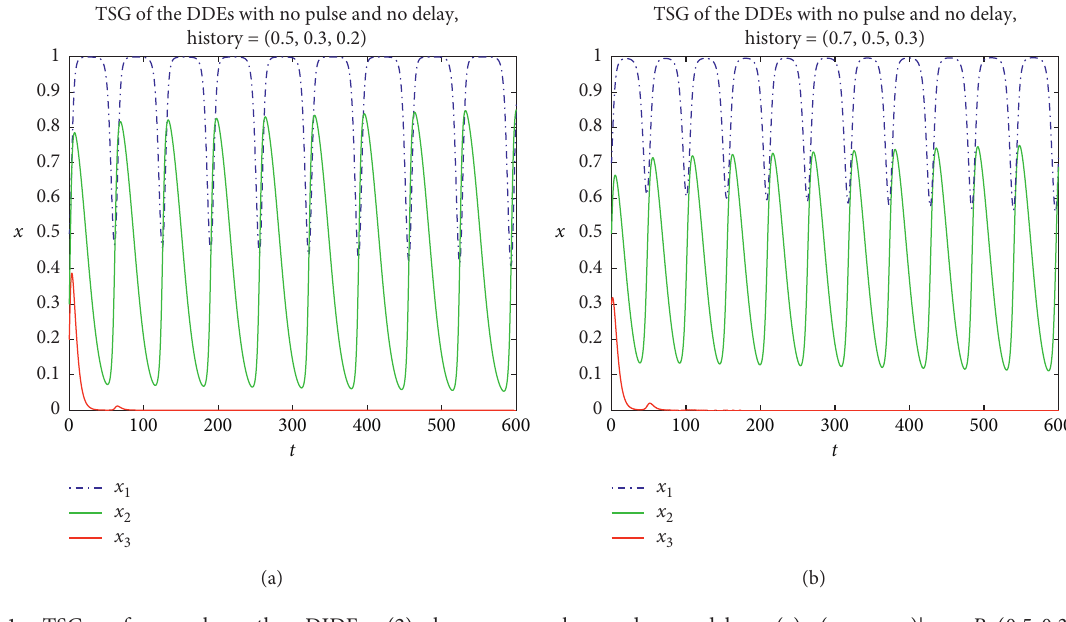
( x , x ,x )| � P ( 0 . 5 , 0 . 3 , 0 . 2 ) and t � 0 1 2 3 0